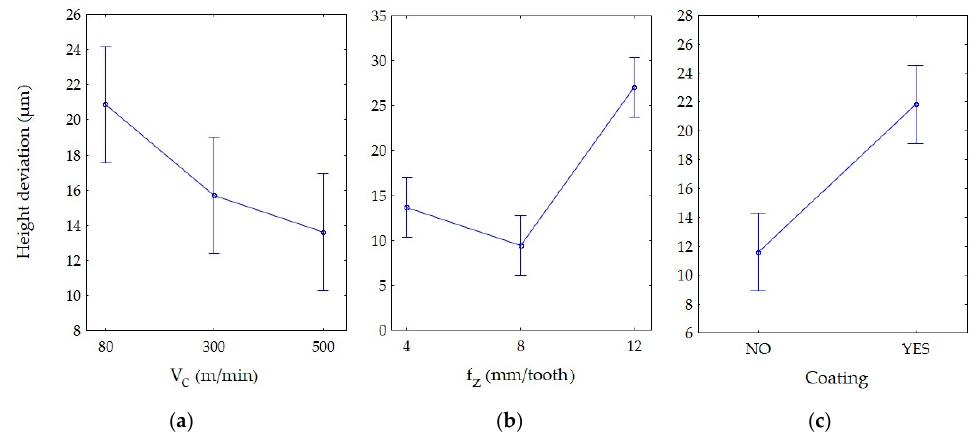
Figure 6. Main effects on the height deviations: ( a ) cutting speed, ( b ) feed and ( c ) presence of the coating.